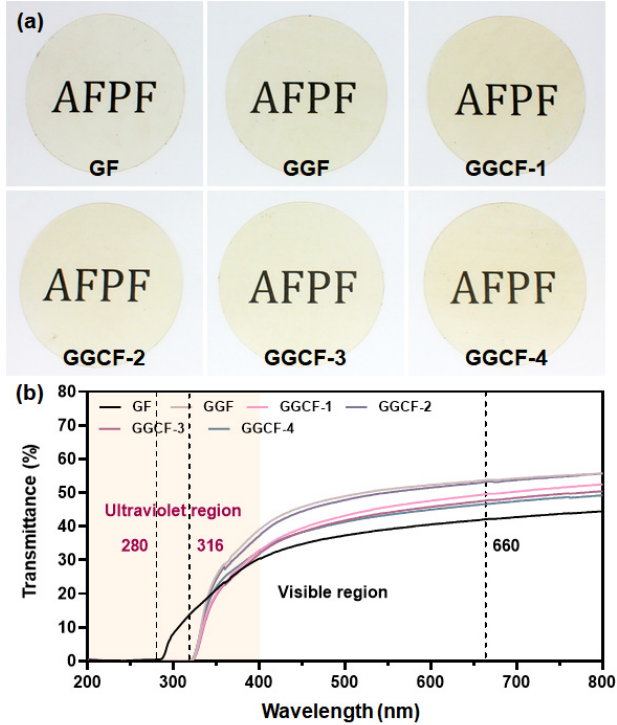
Figure 5. Appearance ( a ) and UV–vis spectra ( b ) of GBFs; AFPF: active food packaging